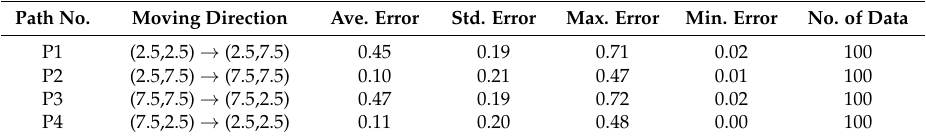
Table 3. Results of error range for moving tag.